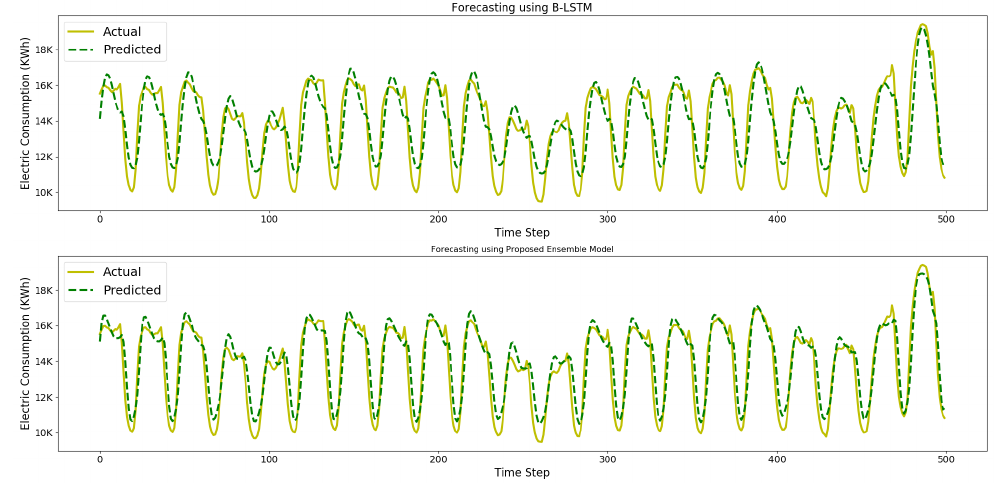
Figure 11. Electric consumption forecasting using proposed ensemble and